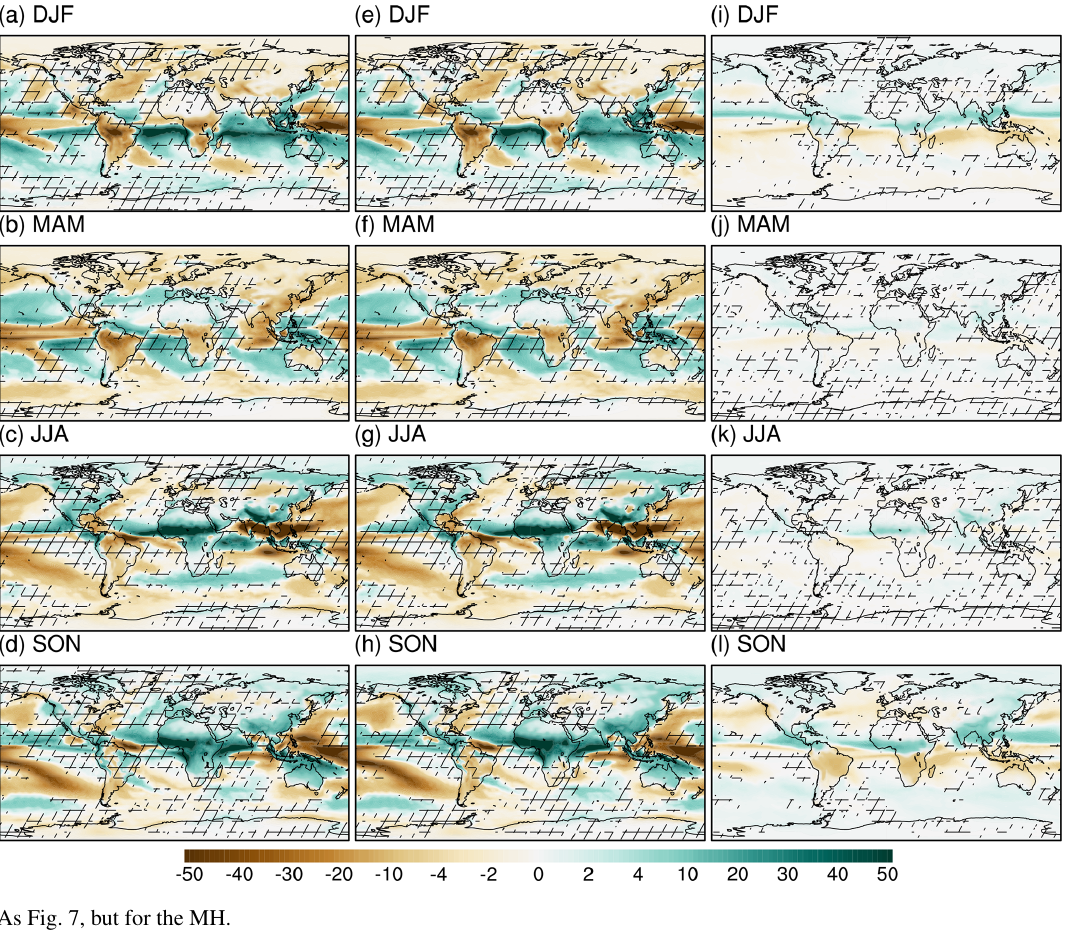
Figure 8. As Fig. 7, but for the MH.